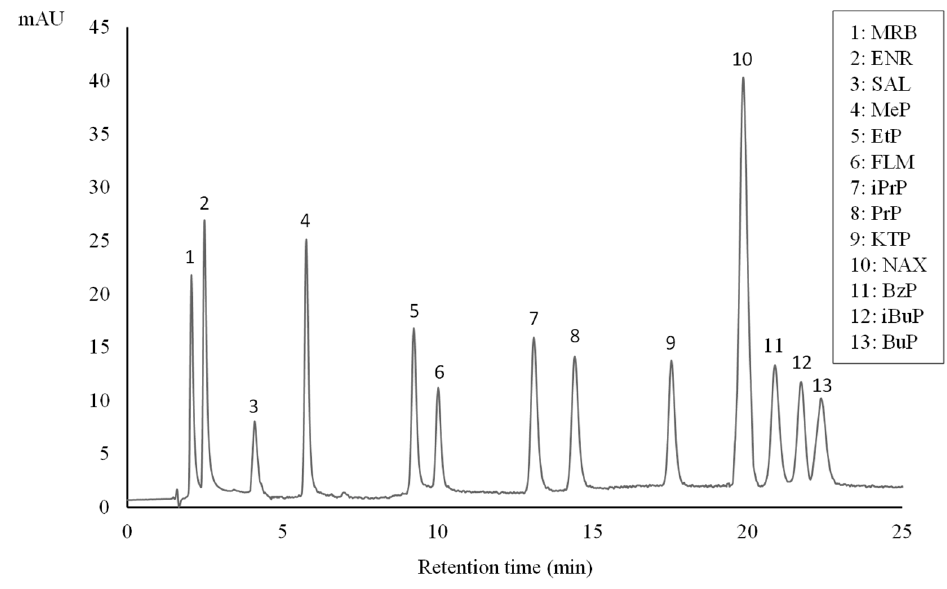
Figure 1. HPLC chromatogram of an aqueous standard solution (100 µgL − 1 ) of parabens, FQs, and NSAIDs.